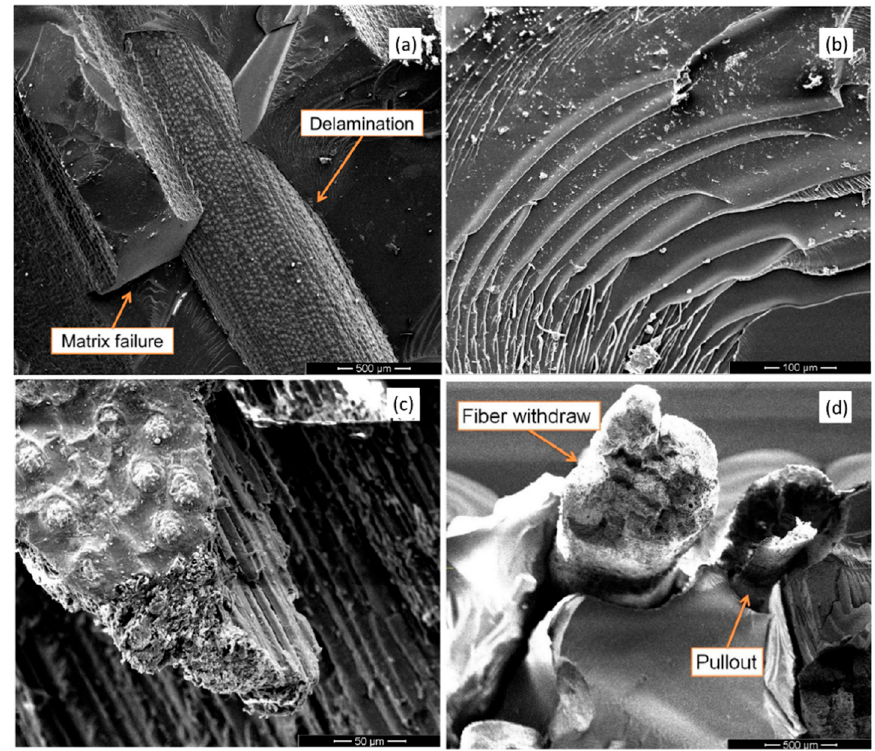
Figure 11. SEM micrograph displaying several micro mechanisms of failure observed in NLFs polymer composites under ballistic impact. Adapted from [158].